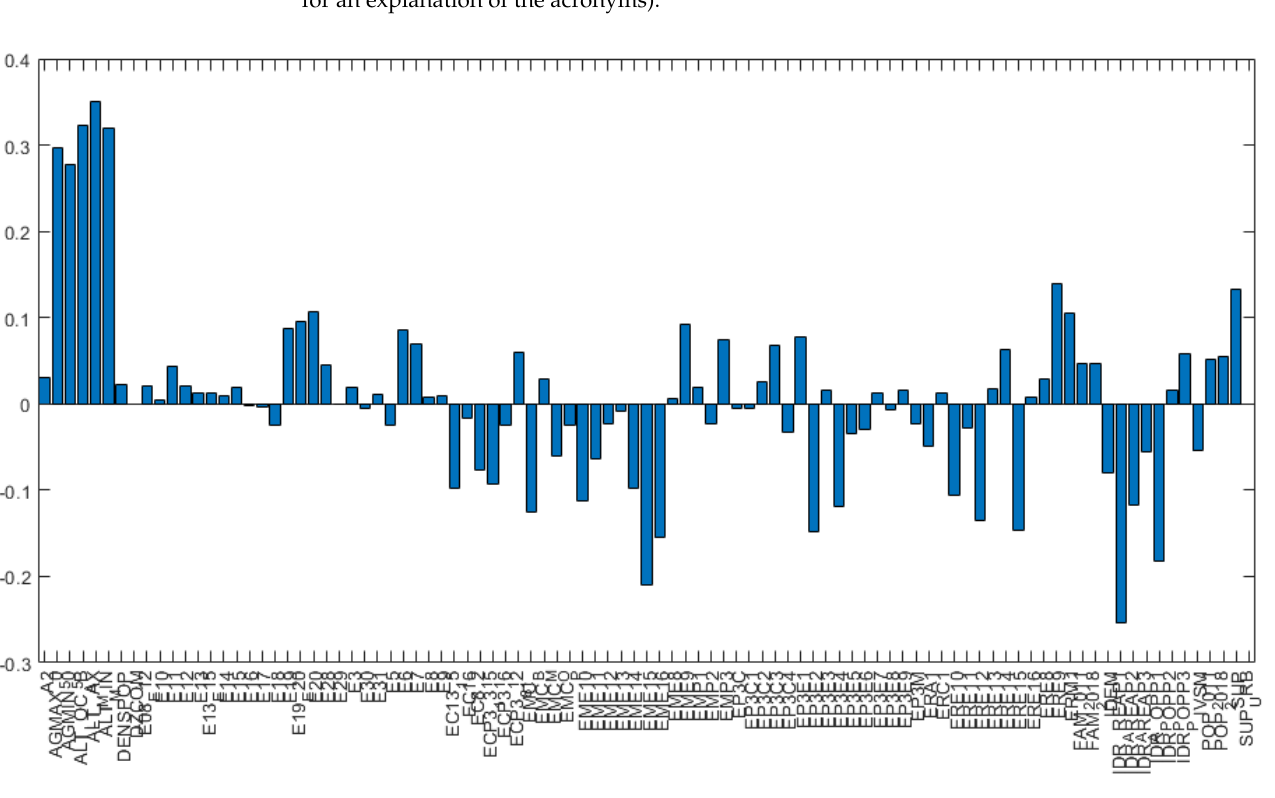
Figure 6. Loading plot of the variables coefficients along the second principal component (see Appendix A for an explanation of the acronyms).